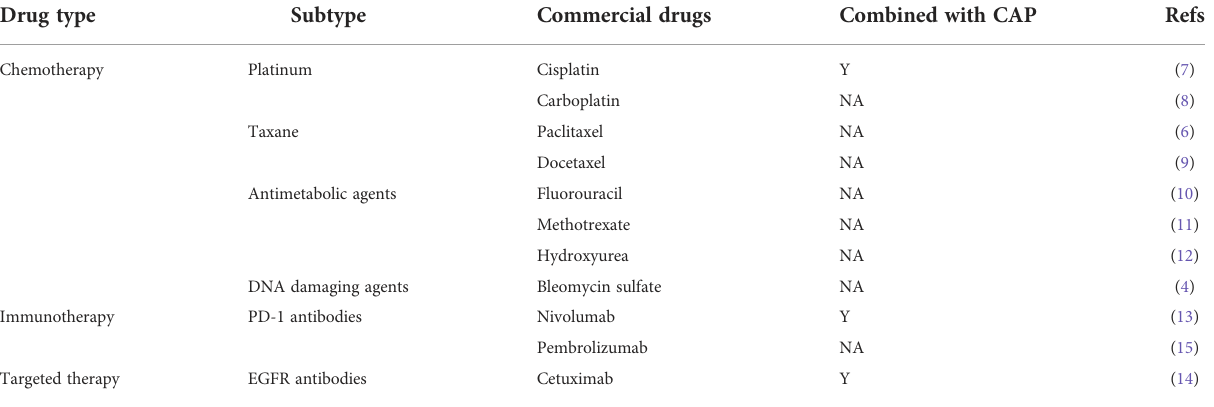
TABLE 1 Commonly used chemotherapeutic drugs for head and neck